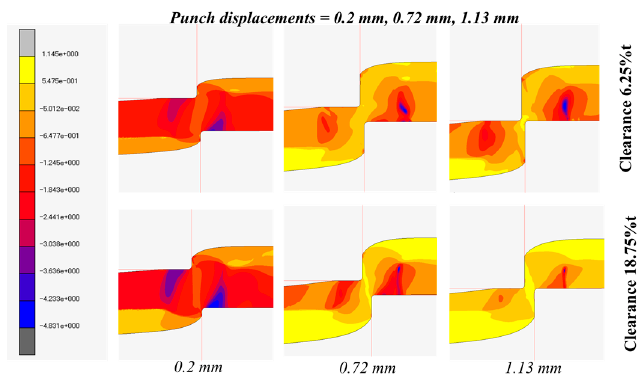
) at different punch displacements for the blank σ eq (cid:3097) (cid:3280)(cid:3292)